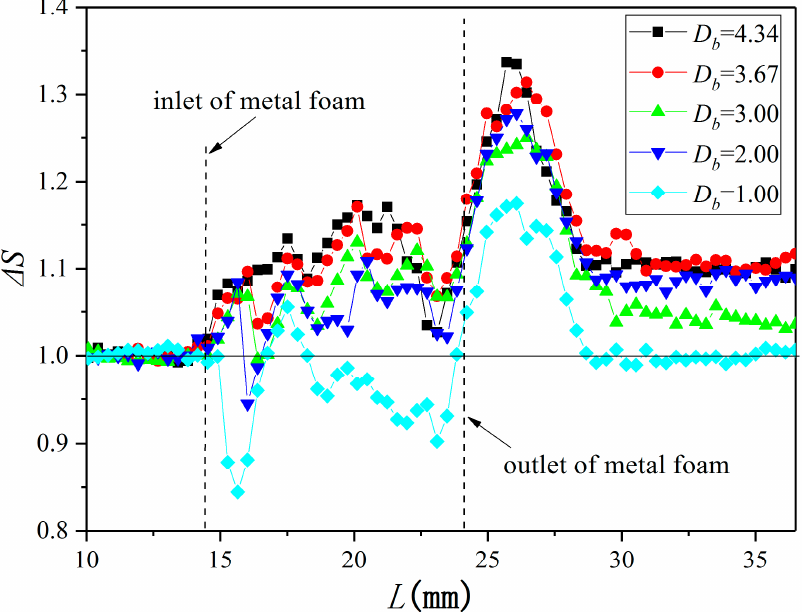
Figure 10. Change of the superficial area of two successive droplets when they pass through a metal foam with different D b values ( L d = 7.32, Ca = 0.061, and D d = 1.33).